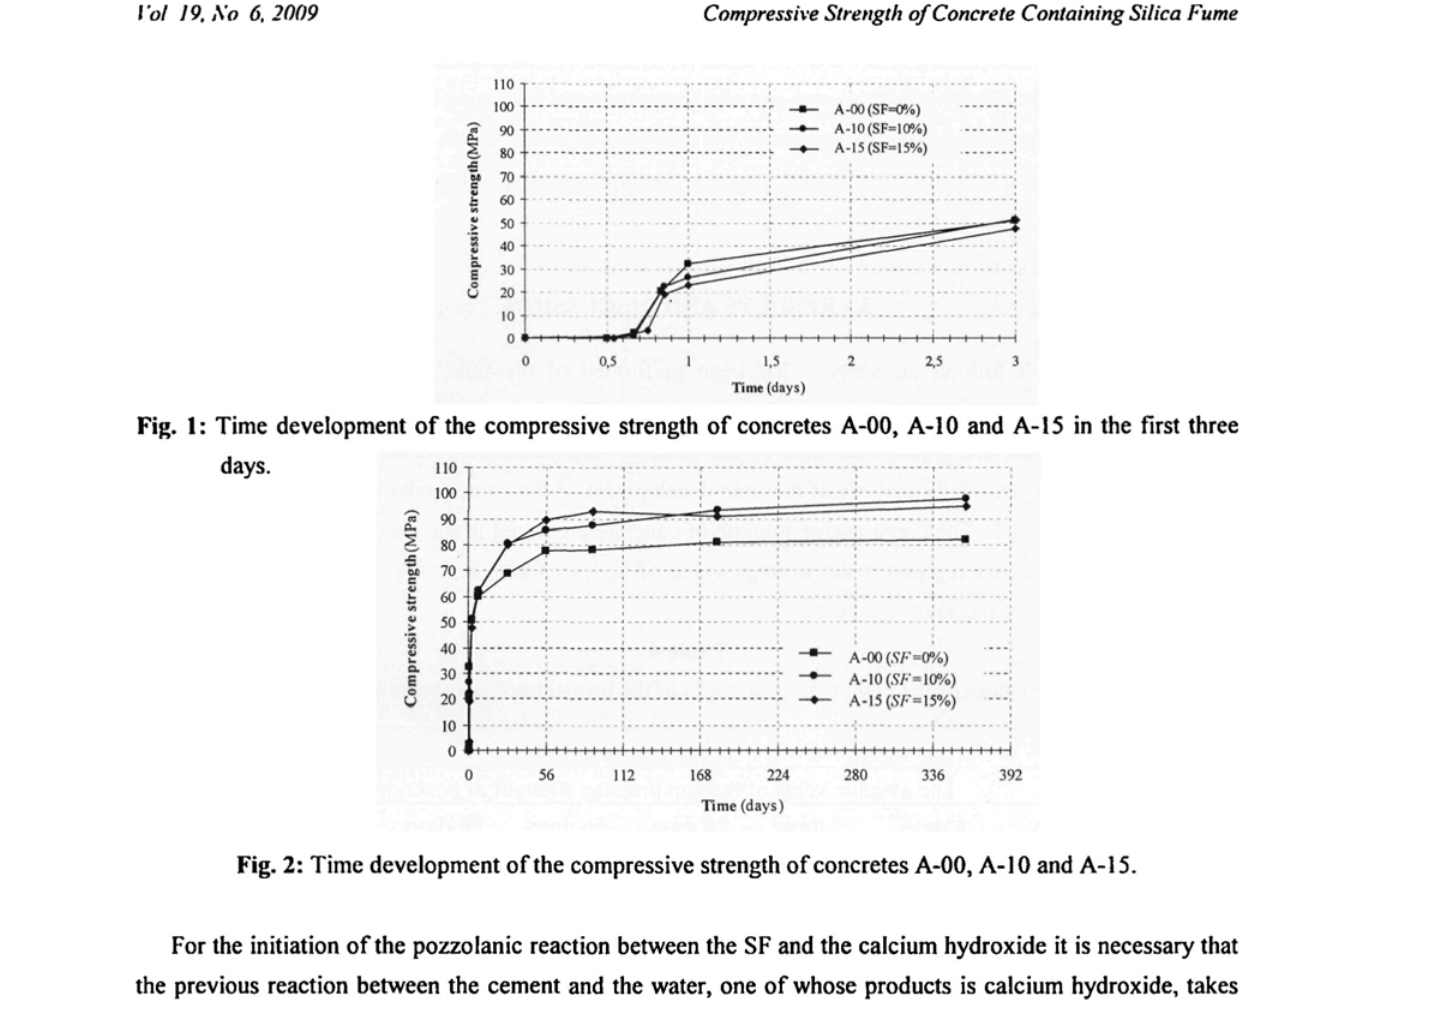
Fig. 2: Time development of the compressive strength of concretes A-00, A-10 and